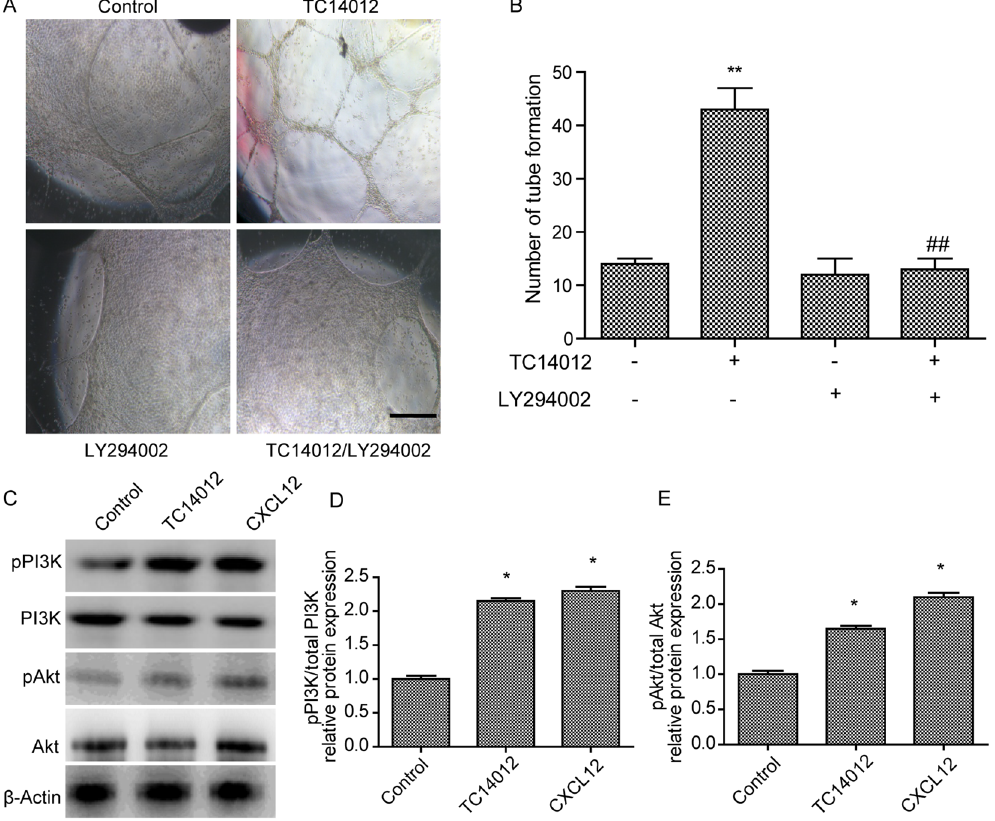
Figure 6. Tube formation mediates by TC14012 is blocked by PI3K/Akt inhibitor LY294002 in HUVECs. ( A ) LY294002 (10 μ M) inhibited tube formation of HUVECs induced by TC14012 (30 μ M). ( B ) Quantitative analysis of the tube formation of HUVECs as shown in A. ( C ) Western blots for PI3K/Akt of HUVECs exposed to TC14012 (30 μ M) or CXCL12 (100 ng/mL). Representative WB showed that TC14012 (30 μ M) or CXCL12 (100 ng/mL) induced protein expression of pPI3K ( D ) and pAkt ( E ) expression in HUVECs. Results are given as mean ± SD of three independent experiments. ** p < 0.01 versus control, ## p < 0.01 versus